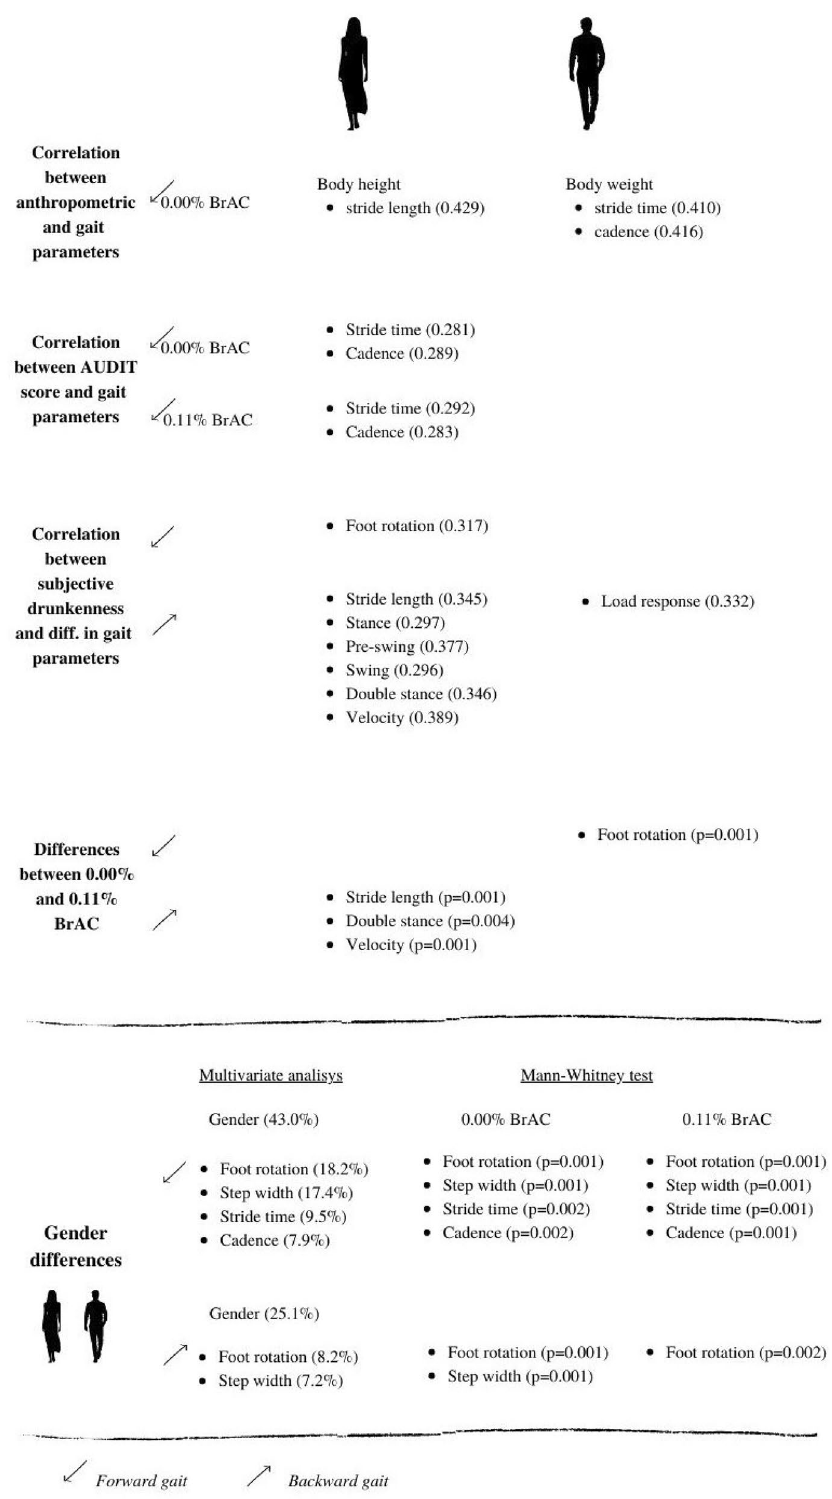
Figure 2. Summary of the results. Canva. https:// www. canva.